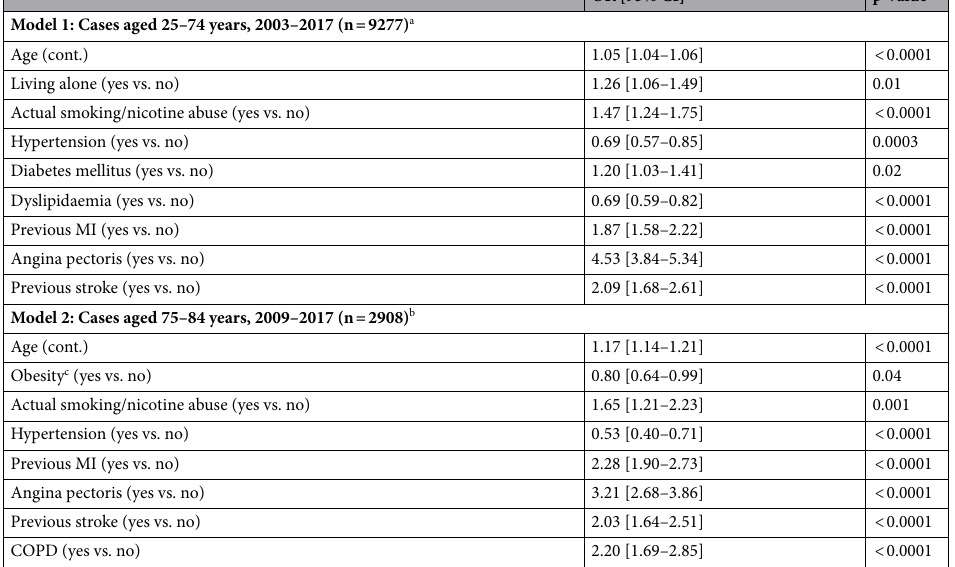
Table 3. Factors associated with prehospital death compared to 28-day survival. MI myocardial infarction, COPD chronic obstructive pulmonary disease. a 1794 observations (n = 854 prehospital death cases; n = 940 cases of 28-day survivors) were deleted due to missing values for the explanatory variables. COPD was not included in this model as information was not available up to 2008. b Note: 768 observations (n = 359 prehospital death cases; n = 409 cases of 28-day survivors) were deleted due to missing values for the explanatory variables. c Obesity reported by last treating physicians (fatal cases) or defined as body mass index > = 30 kg/m 2 (non-fatal